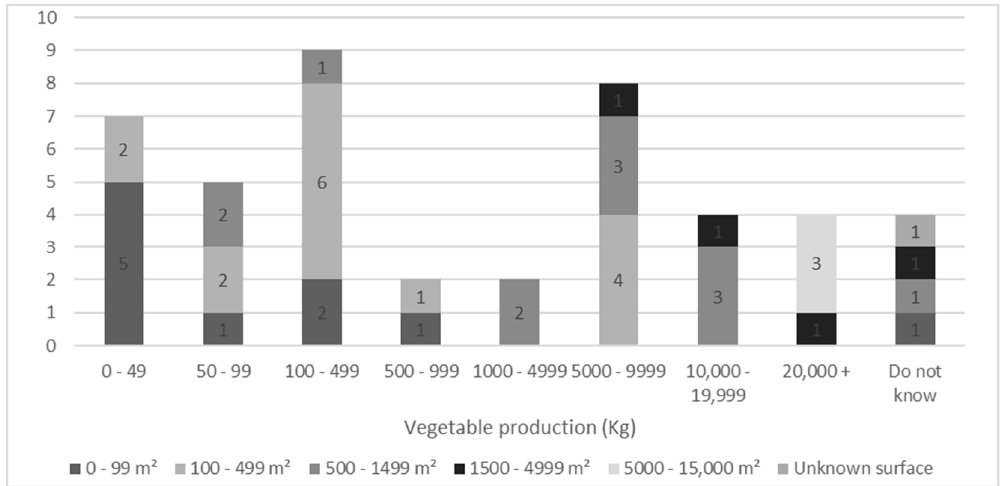
Figure 8. Plant yield and total surface of the aquaponic systems of the respondents.